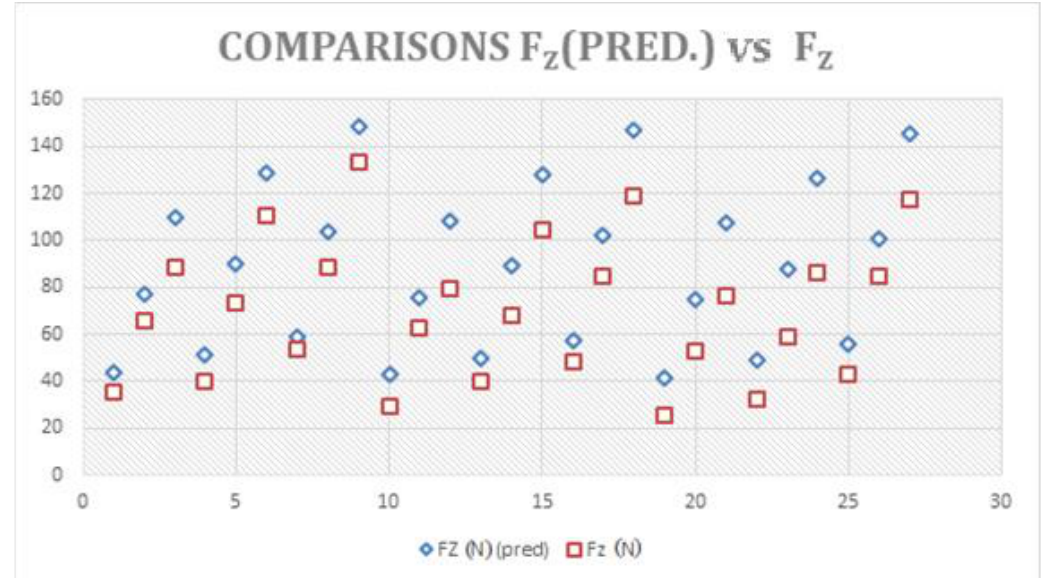
Figure 11. Comparisons of predicated and measured